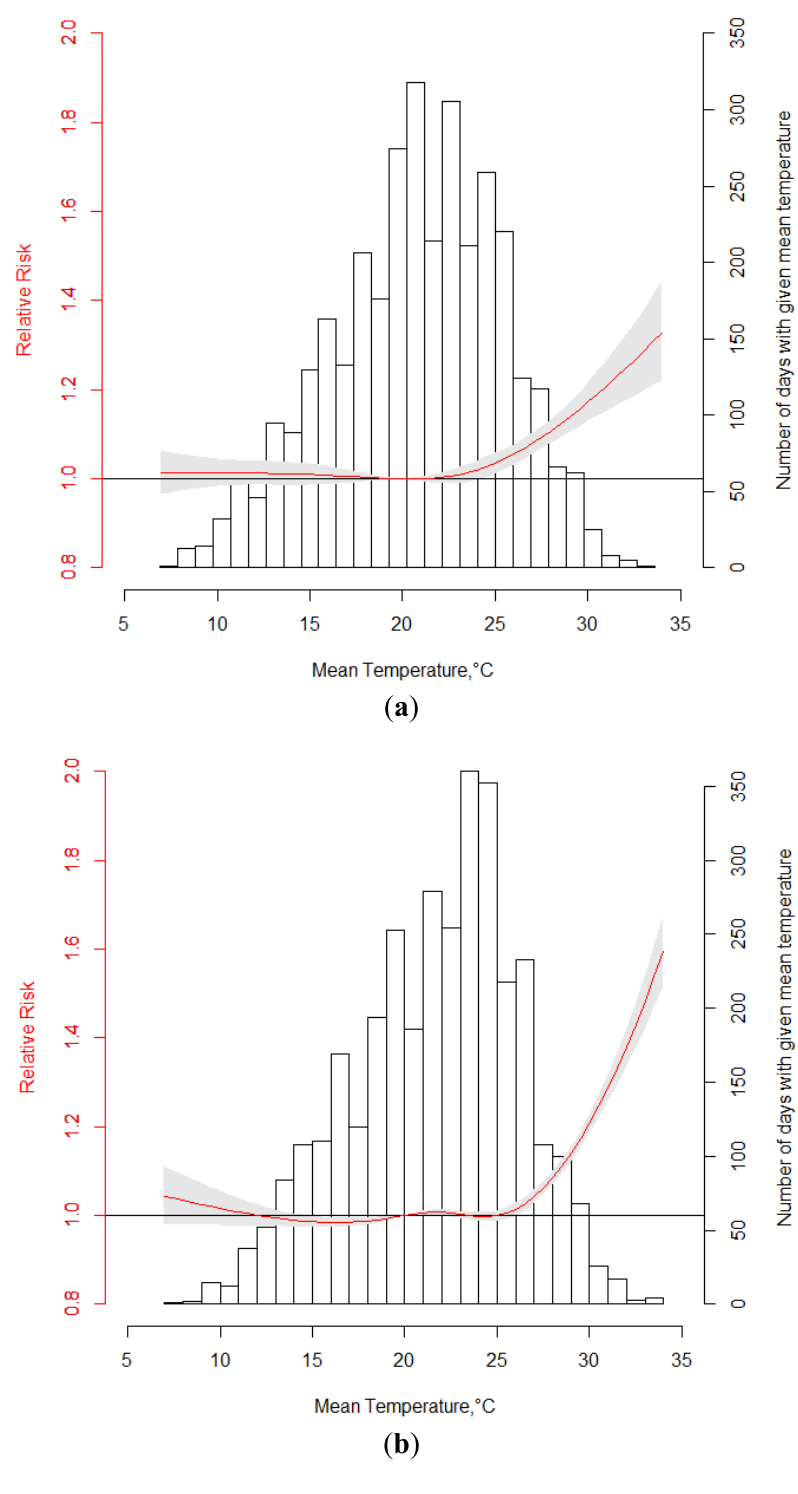
Figure 1. Temperature ‒ mortality curves of overall cumulative relative risk over four days of lag and mean summer temperature histograms for ( a ) Boston ( b ) New York City and ( c ) Philadelphia based on data between 1985 and 2006. Relative risks calculated using a distributed lag non-linear model with natural cubic splines with four degrees of freedom for the temperature and the lag and 20 °C as a reference